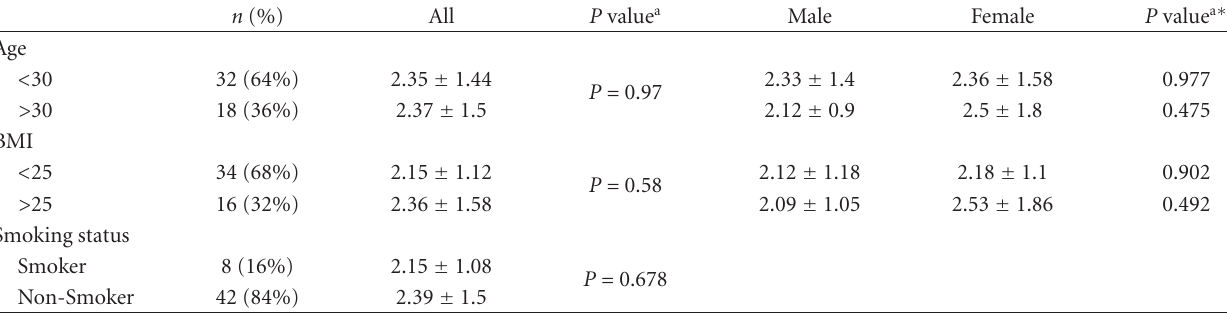
Table 2: Urinary 15FIP (ng/mg creatinine) according to subjects age, body weight and smoking status.